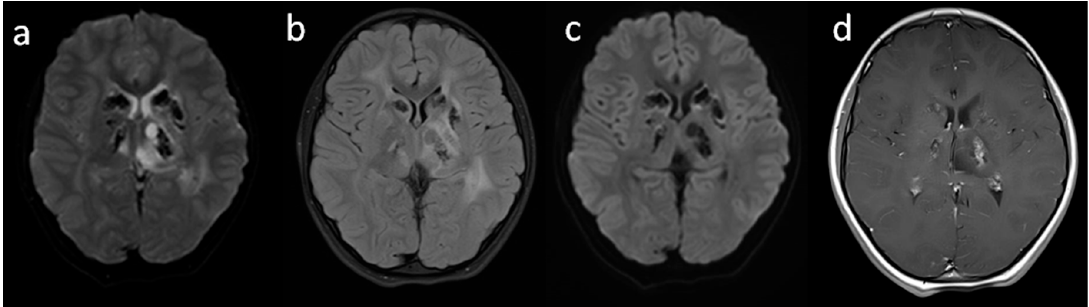
Figure 2. Second brain MRI; one year later, axial plane: ( a ) T2; ( b ) Flair T2; ( c ) T1; ( d ) T1 + CE sequences, corresponding calcification artifacts, small left thalamic cyst and white matter hyperintensity.